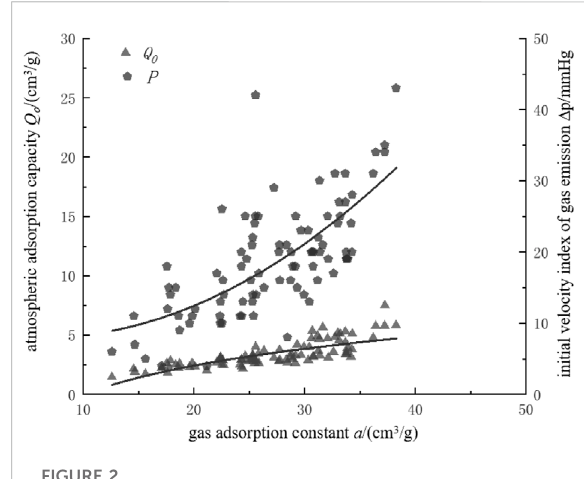
FIGURE 2 Relationship between parameters Q 0 , Δ p and a in 90 coal